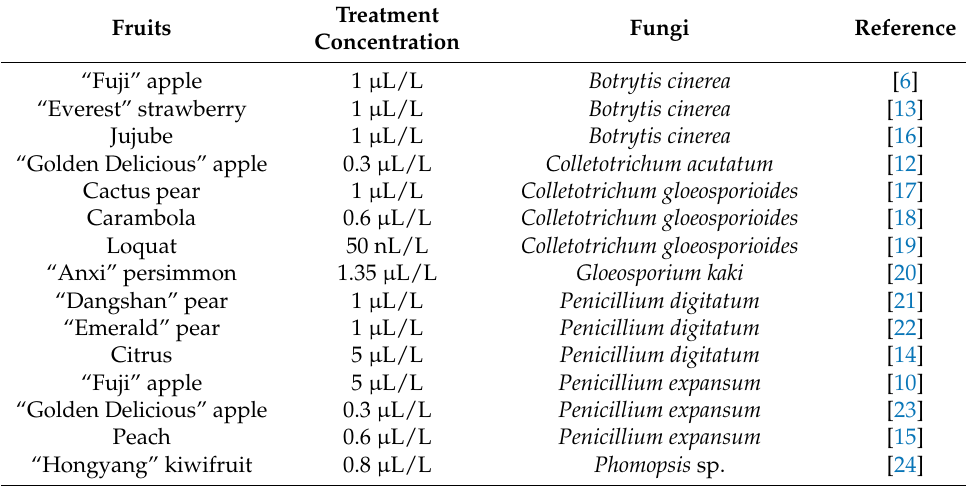
Table 1. Studies on the induced resistance effect of 1-MCP treatment on different types of fungus in postharvest